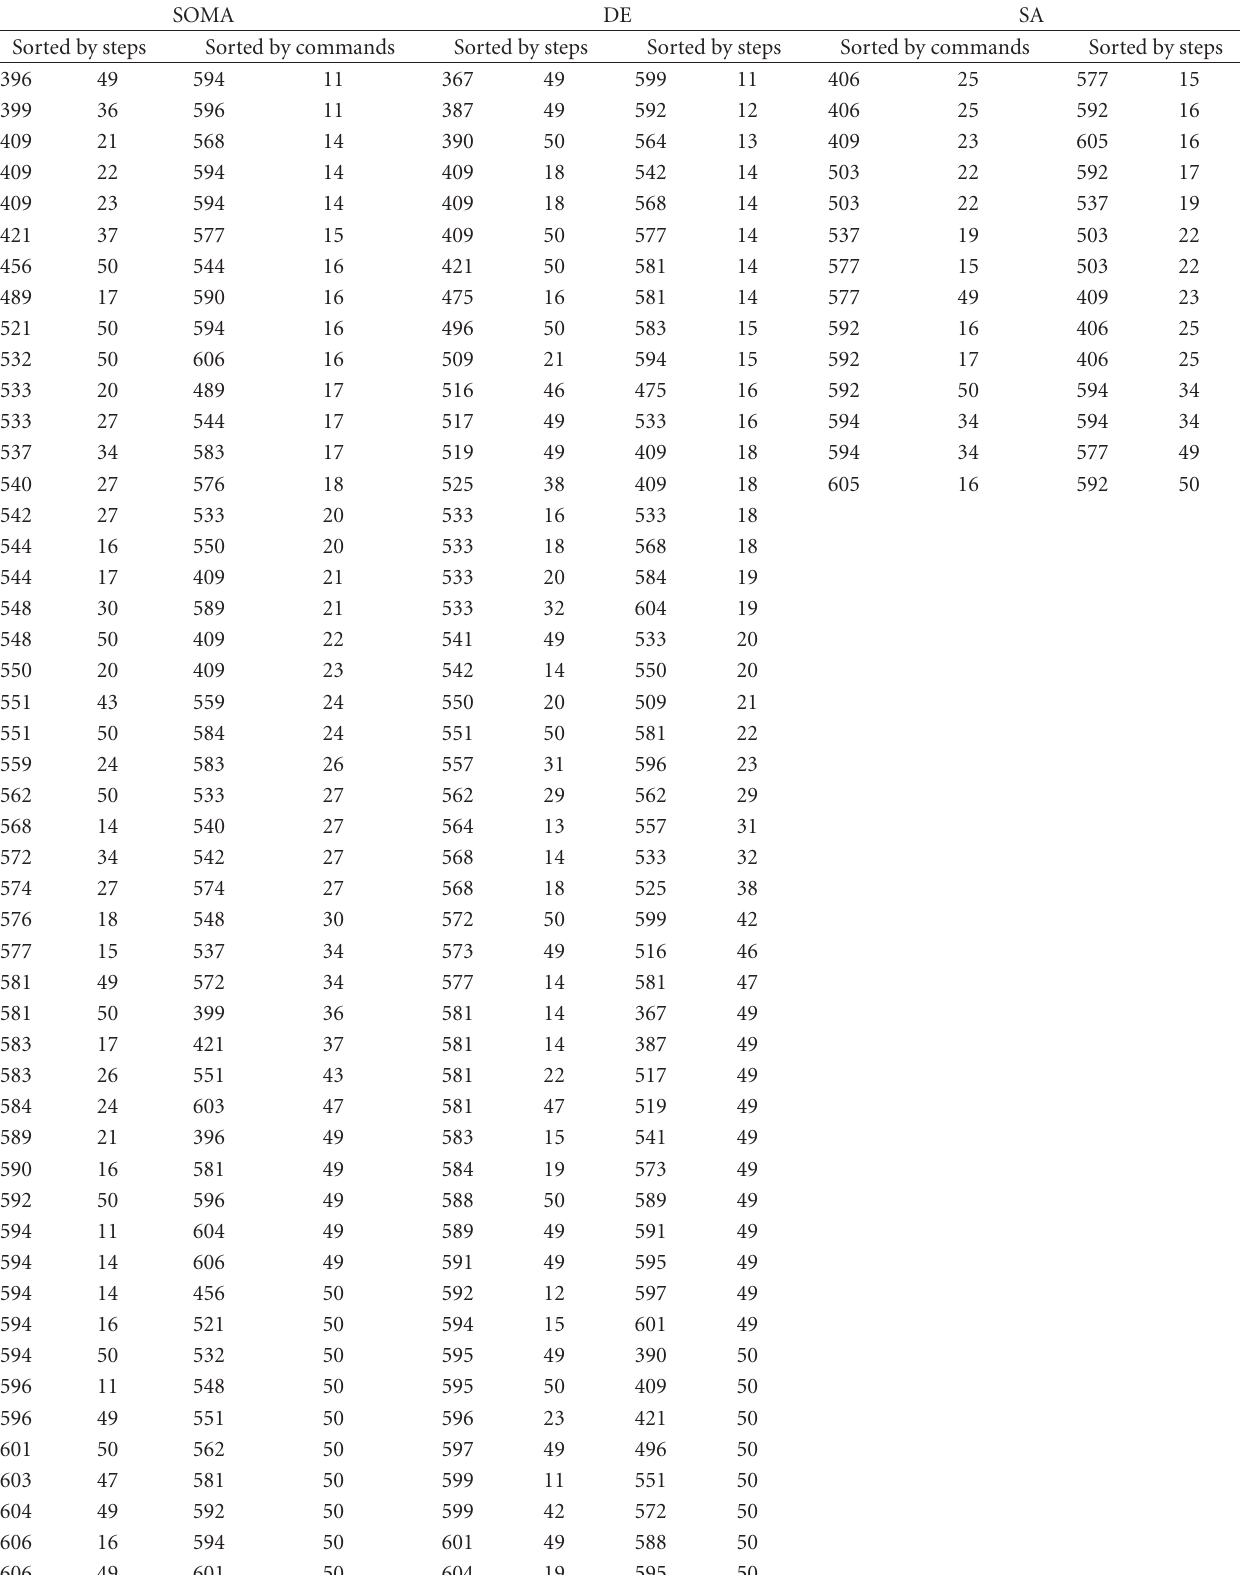
Table 7: Sorted numbers of steps and commands for all